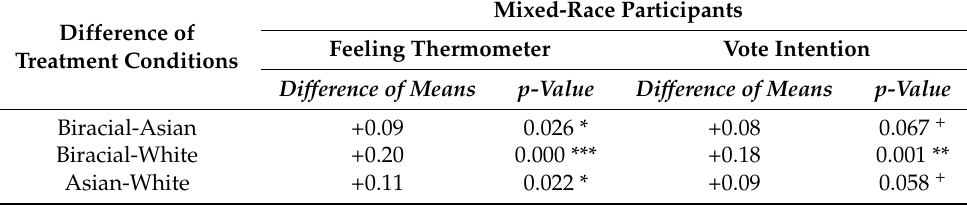
Table 2. Results from difference-of-means t -tests for all possible treatment group comparisons in Figure 2. Difference of Treatment